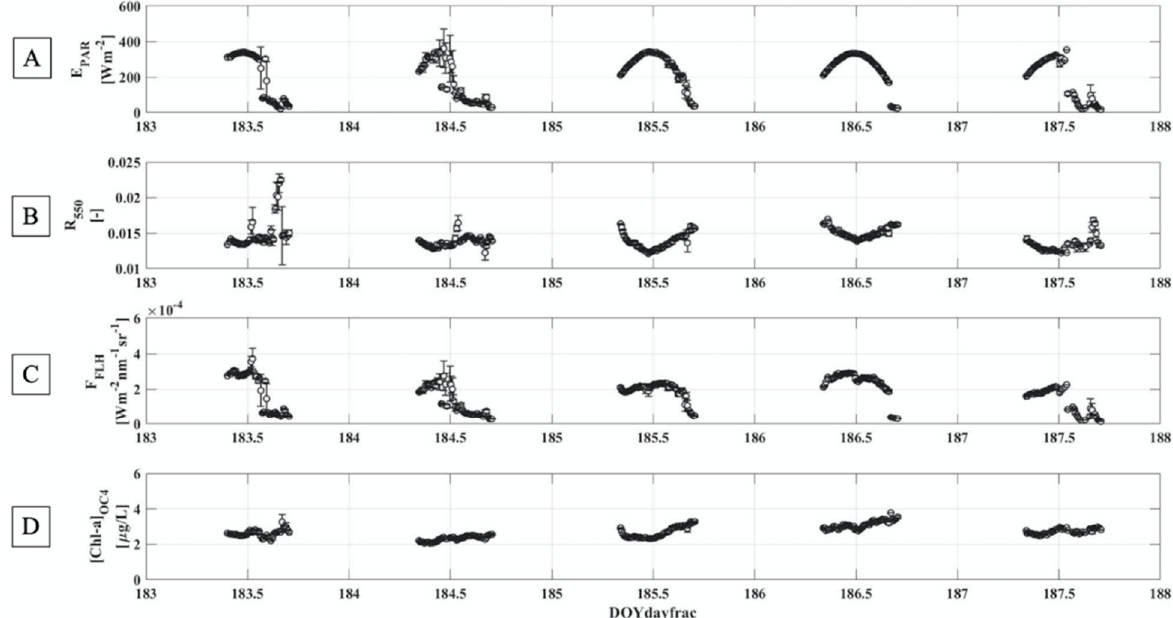
Figure 7. ( A ) shows the irradiance integrated over the PAR spectral range, between 400 and 700 nm; ( B ) shows the reflectance evaluate at 550 nm; ( C ) shows the fluorescence proxy obtained with the dynamically waveband FLH approach; ( D ) displays the spectral index linked to the chlorophyll-a concentration. Data shown represent the mean values (n max per interval ~10), averaged on a time interval of 10 min, while the error bars correspond to the standard deviations.